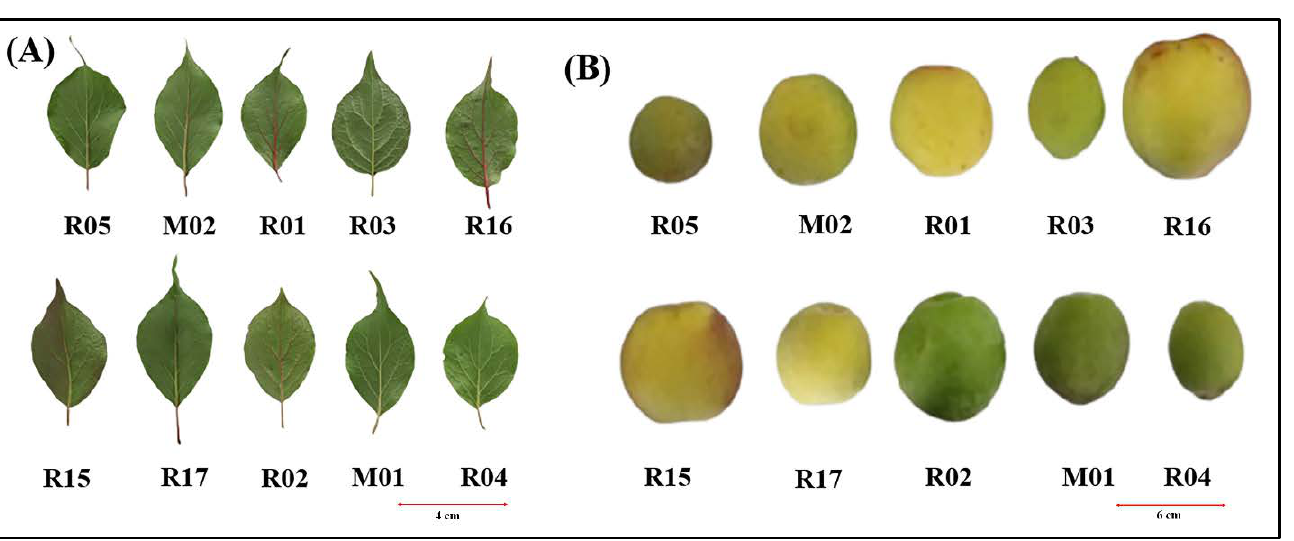
Figure 1. Leaf and fruit samples of the 10 accessions of Prunus mume : ( A ) leaf; ( B ) fruit. The 10 accessions comprised R05, M02, R01, R03, R16, R15, R1, R02, M01 and R04.